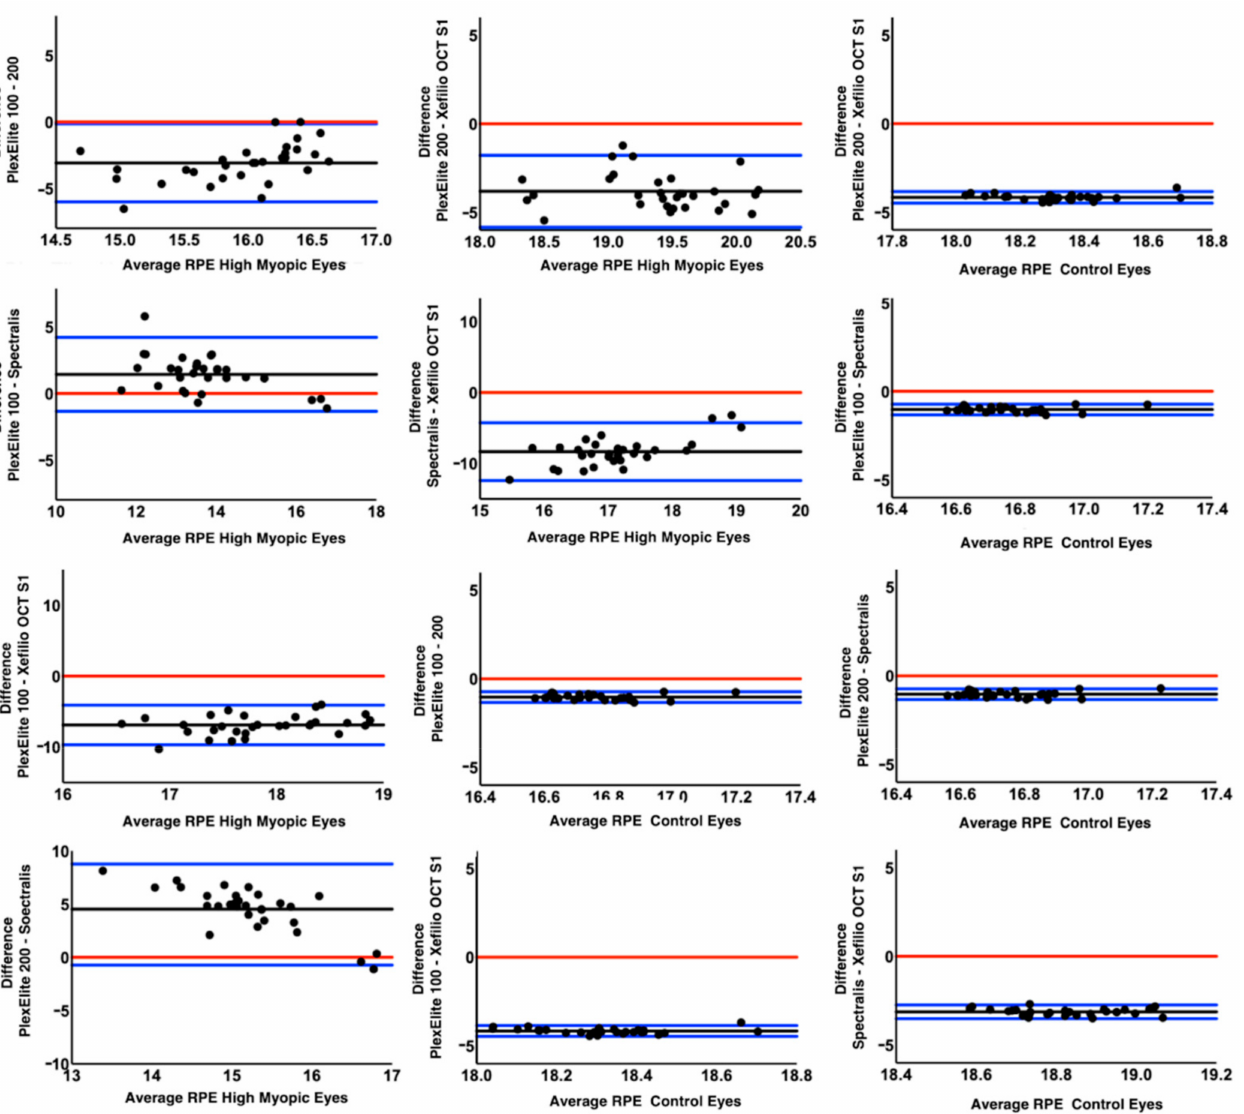
Figure 4. Bland-Altman plots comparing the amount of visible retinal pigment epithelium between the different optical coherence tomography devices for the vertical scans in high myopia cohort and controls emmetropic eyes. The black lines indicate the mean difference between the different devices. The blue lines show the upper and lower limits of agreements. The red line denotes the zero difference between the